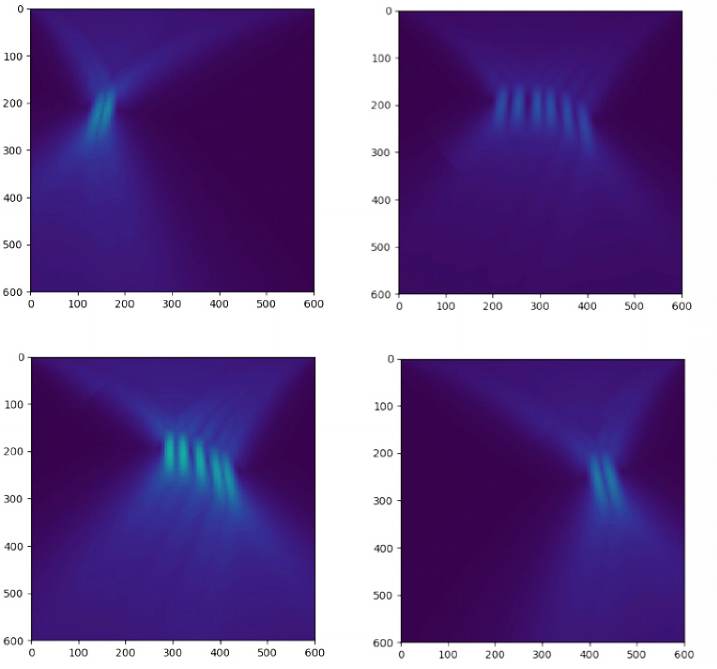
Figure 10. The screenshots of the output energy